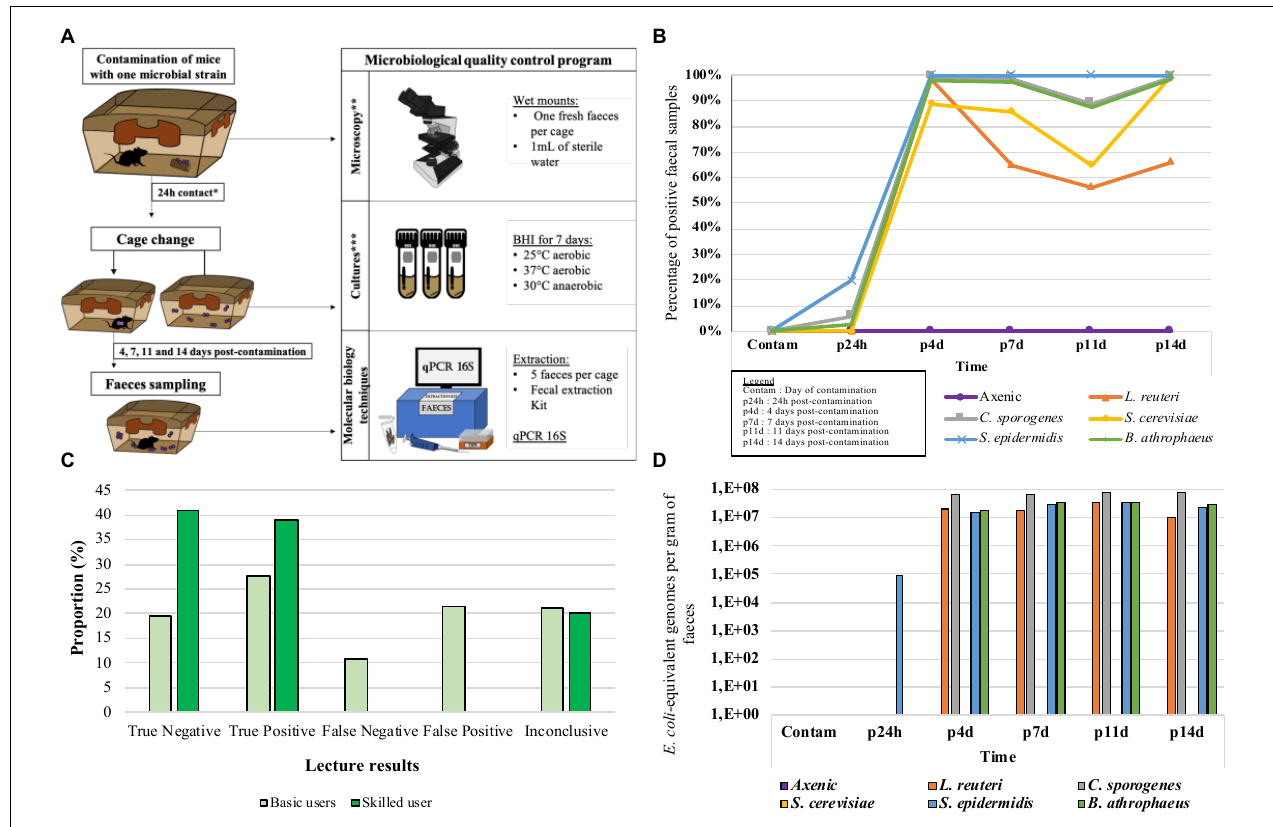
FIGURE 2 | In situ protocol and results for the three optimized methods. (A) In situ protocol. *24h post-contamination cage change was not applicable for the second attempt only, applicable to 2 GF, 3 LR, 3 SC, and 2 BA. **3 basic and 1 skilled microscopists performed the blind wet mounts lectures to determine microscopy method effectiveness in situ . ***Exceptionally for the in situ protocol, 19 samples were taken for the culture method. 17 tubes were incubated in the microorganism’s optimal condition, and the two other tubes were incubated in the two other conditions. (B) Likelihood of detecting spiked microbial contamination when testing the culture method effectiveness in situ , expressed in percentage of positive samples. (C) Proportions of the 5 types of results obtained from 4 microscopists during the examination of faeces sample from microbially spiked mice in order to test the effectiveness of the microscopic method in situ. (D) DNA concentrations of each organism found in faces of spiked mouse in order to test the effectiveness of the molecular method in situ.